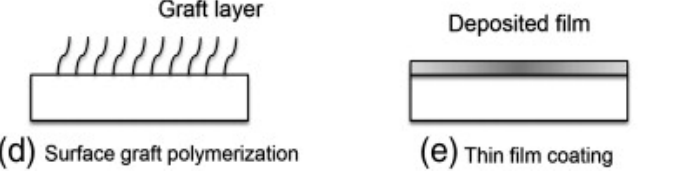
Figure 6. Schematic representation of the surface modifications of polymers by plasma treatments: ( a ) introduction of functional groups, ( b ) introduction of surface roughness, ( c ) crosslink formation, ( d ) surface graft polymerization and ( e ) thin film coating (reproduced with permission from [76]).